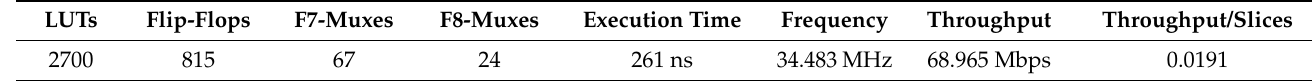
Table 1. The characteristics of the proposed lightweight-based security scheme.